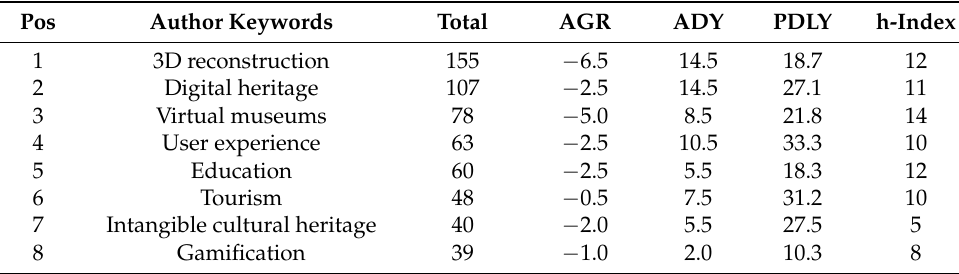
Table 1. Growth indicators of selected trend